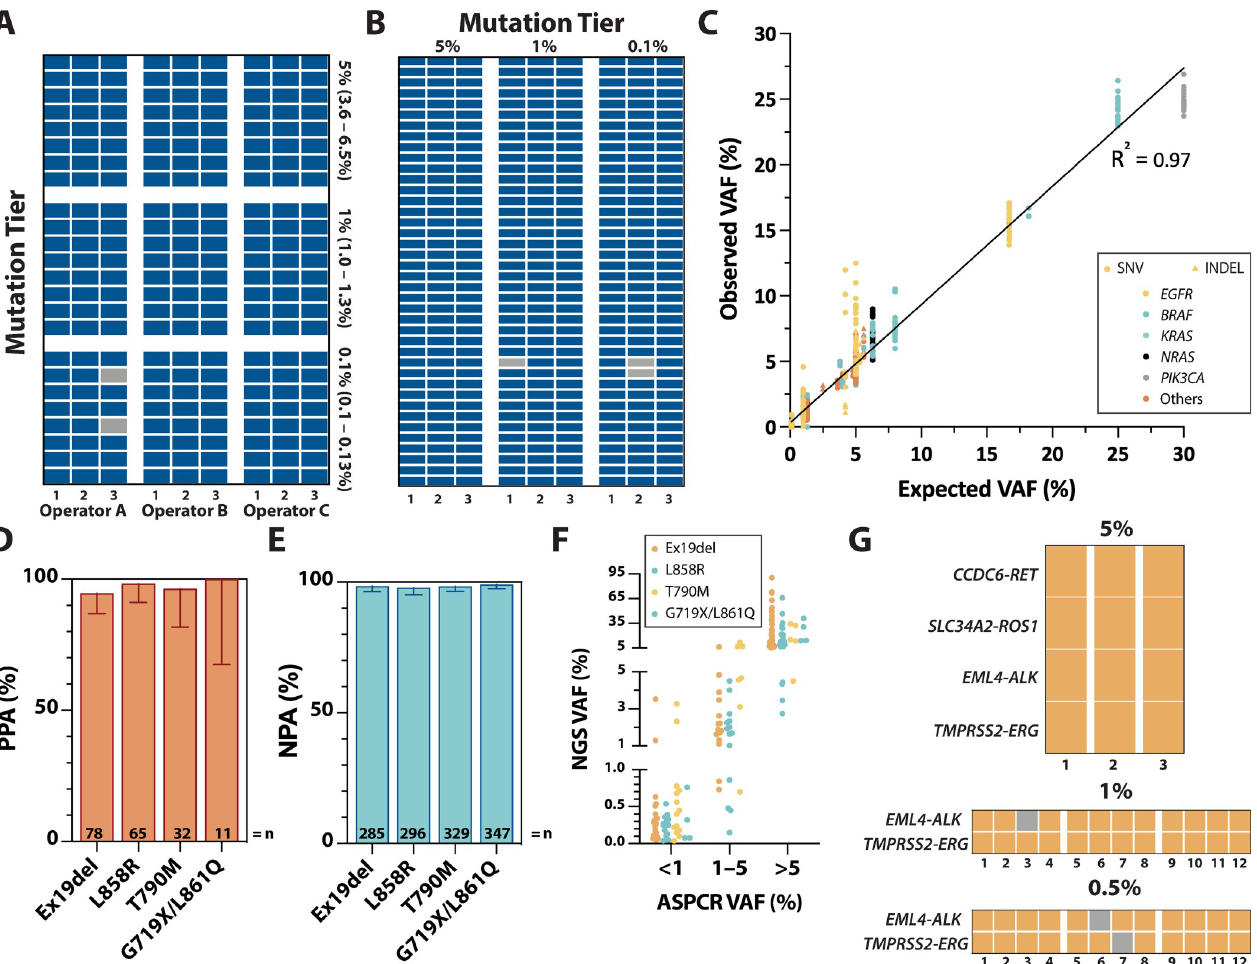
Fig 2. Analytical performance for (A-F) SNV/INDEL and (G) fusion detection. Hit/miss observations across different single nucleotide variant (SNV)/ insertion-deletion (INDEL) mutation tiers and operators/repeats in (A) HD780 and (B) Tru-Q reference standard materials. Each row represents a unique SNV/INDEL variant. Detected SNV/INDEL variants are highlighted in blue and missed variants in gray. (C) Correlation between expected and observed SNV/ INDEL variant allele frequencies (VAF) based on linear regression. Circles represent SNVs and triangles INDELs. Each color represents a unique gene. ( D ) Positive percent agreement (PPA), ( E ) negative percent agreement (NPA) and ( F ) positive VAF concordance of LiquidHALLMARK EGFR variant calls relative to allele-specific PCR (AS-PCR) in 355 clinical lung cancer samples. Error bars in D and E represent 95% CI. Each color in ( F ) represents a unique class of EGFR variant; ex19del, exon 19 deletion. ( G) Hit/miss observations across different fusion mutation tiers and repeats in HD786 reference standard and contrived admixtures of fragmented cell-line DNA. Each row represents a unique fusion. Detected SNV/INDEL variants are highlighted in orange and missed variants in